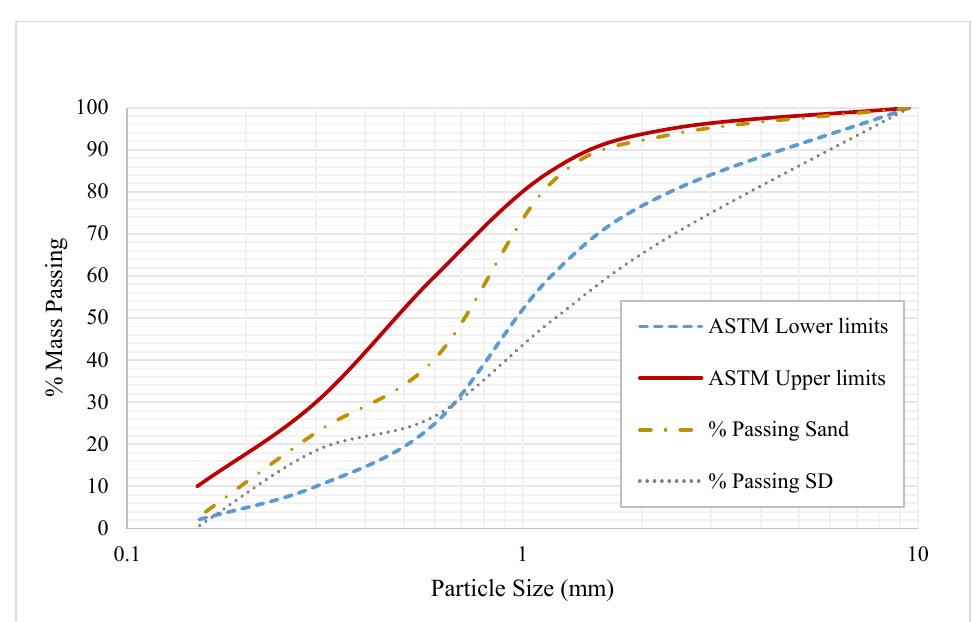
Figure 2. Particle size range of sand and SD.